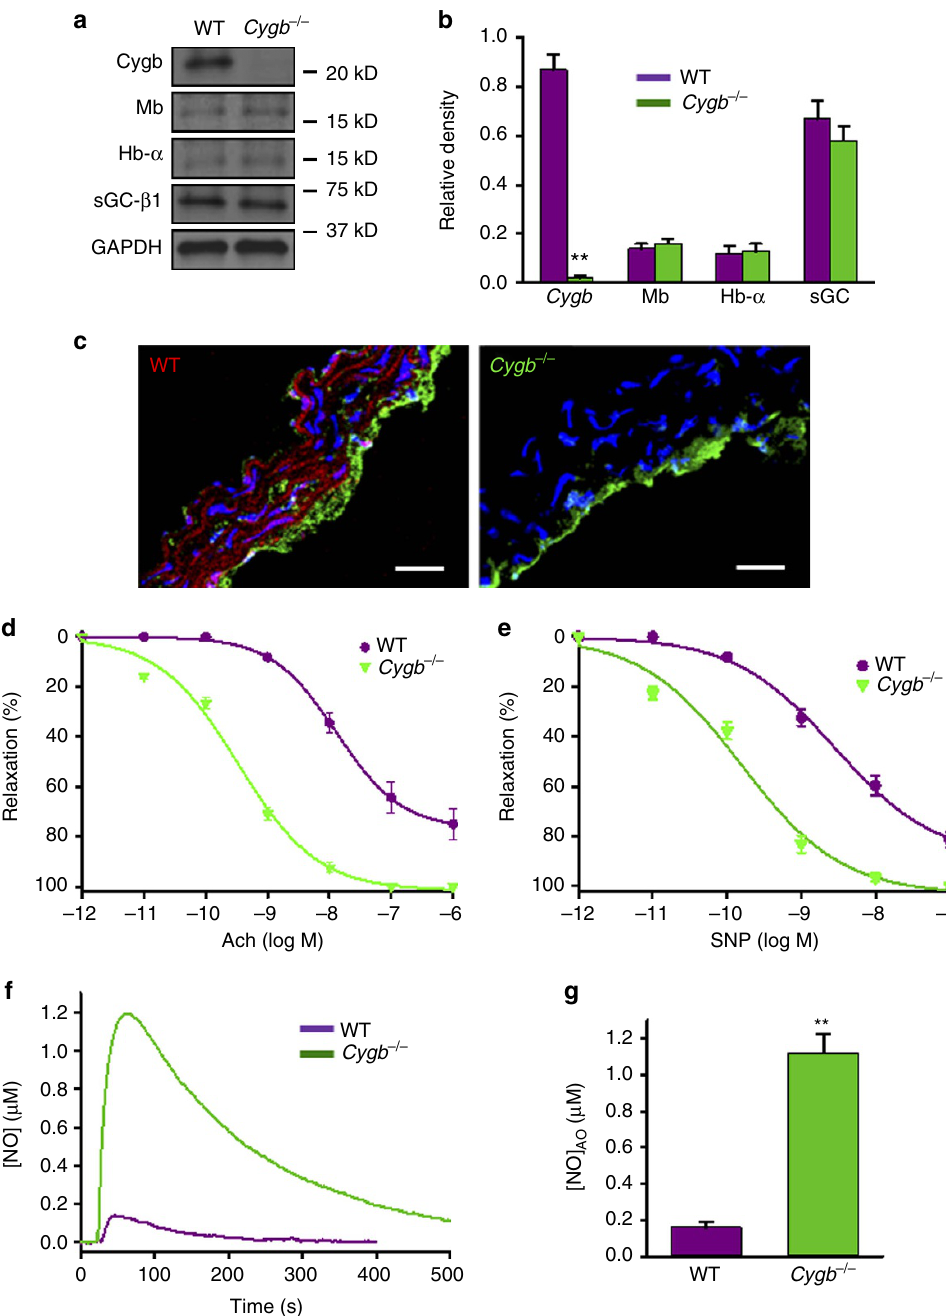
Figure 5 | Expression of proteins in the NO-sGC pathway, NO-dependent vasodilation and vascular NO metabolism rate in WT and Cygb (cid:3) / (cid:3) mice. Expression of Cygb, Mb, Hb- a , sGC- b 1 and GAPDH in aortas of WTand Cygb (cid:3) / (cid:3) mice. Positions of nearest molecular weight markers are shown ( a ) and their relative band density ( b ). Of note, to be able to detect Mb and Hb- a , 2.5-fold higher levels of homogenate protein were used compared to Cygb. Cygb staining (red) in WTand Cygb (cid:3) / (cid:3) aortic sections with endothelium staining for eNOS (green). Scale bars, 50 m m ( c ). The phenylephrine-precontracted aorta of Cygb (cid:3) / (cid:3) mice was much more sensitive to both Ach-induced relaxation ( d ) and SNP-induced relaxation ( e ). The EC 50 for Ach-induced relaxation of Cygb (cid:3) / (cid:3) and WTmouse aortas is 0.33 and 13nM, respectively. EC 50 for SNP-induced relaxation of Cygb (cid:3) / (cid:3) and WTmouse aortas is 0.15 and 3.0nM, respectively ( d , e ). Each data point in d , e represents the mean of six independent experiments. The measured NO concentration at the electrode surface after NO diffuses across the aortic wall, which is proportional to the NO flux through the vessel wall, of WT (violet) and Cygb (cid:3) / (cid:3) (green) mice is shown ( f ). The measurement method for NO concentration was as previously described 35 . NO was injected into the solution to achieve an initial concentration of 3 m M. The peaks observed correspond to the maximum NO flux. The mean and standard errors of the peak NO concentration detected ( g ). Error bars: mean ± s.e.m., n ¼ 5 per group, ** P o 0.01 WT versus Cygb (cid:3) / (cid:3) ; P values determined using a two-tailed t